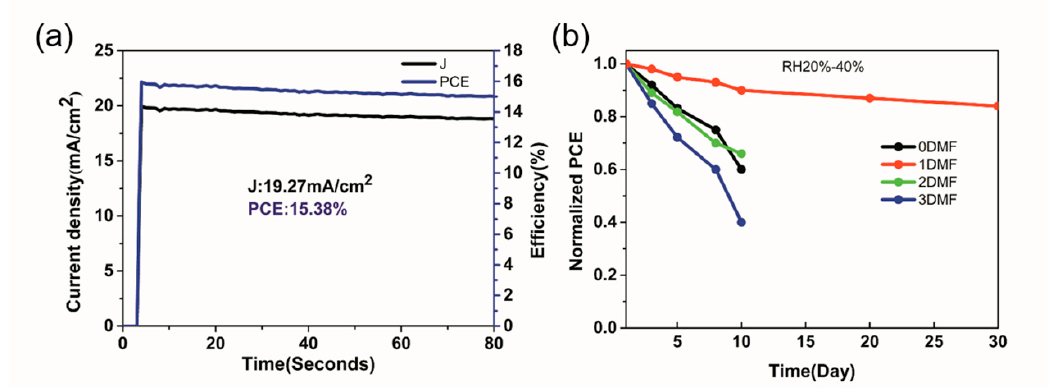
Figure 10. ( a ) Steady-state current density and PCE of 1DMF device under continuous illumination at maximum power point; ( b ) stability test for 0DMF, 1DMF, 2DMF, and 3DMF PSCs in air condition (RH 20–40%) without sealing.